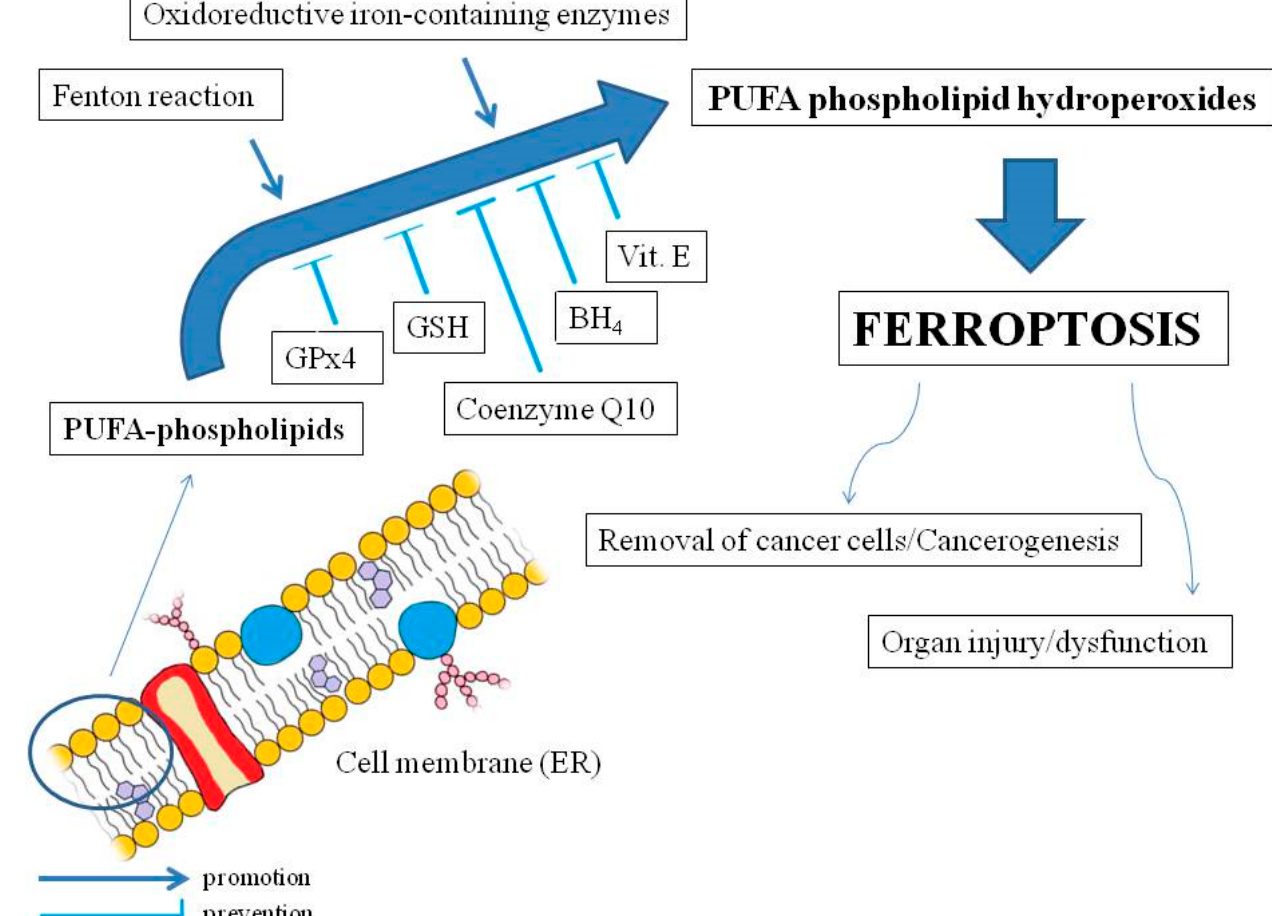
Figure 1. The main mechanisms of ferroptosis and the effects on the human organism. Polyunsaturated fatty acids (PUFAs) in membrane phospholipids (mainly endoplasmic reticulum, ER) are oxidized by reactive oxygen species from the Fenton reaction or as a result of activity of oxidoreductive iron-containing enzymes. The oxidation may lead to ferroptosis by accumulation of PUFA phospholipid hydroperoxides, which may be inhibited by soluble glutathione peroxidase 4 (GPx4) and glutathione (GSH), as well as lipophilic membrane protectors such as coenzyme Q10, tetrahydrobiopterin (BH4), and vitamin E. Ferroptosis may be implicated in cancer cell death but may also promote carcinogenesis as well as organ injuries and dysfunctions (slightly modified cell membrane diagram, courtesy of Holly Barker/The Science Hive).